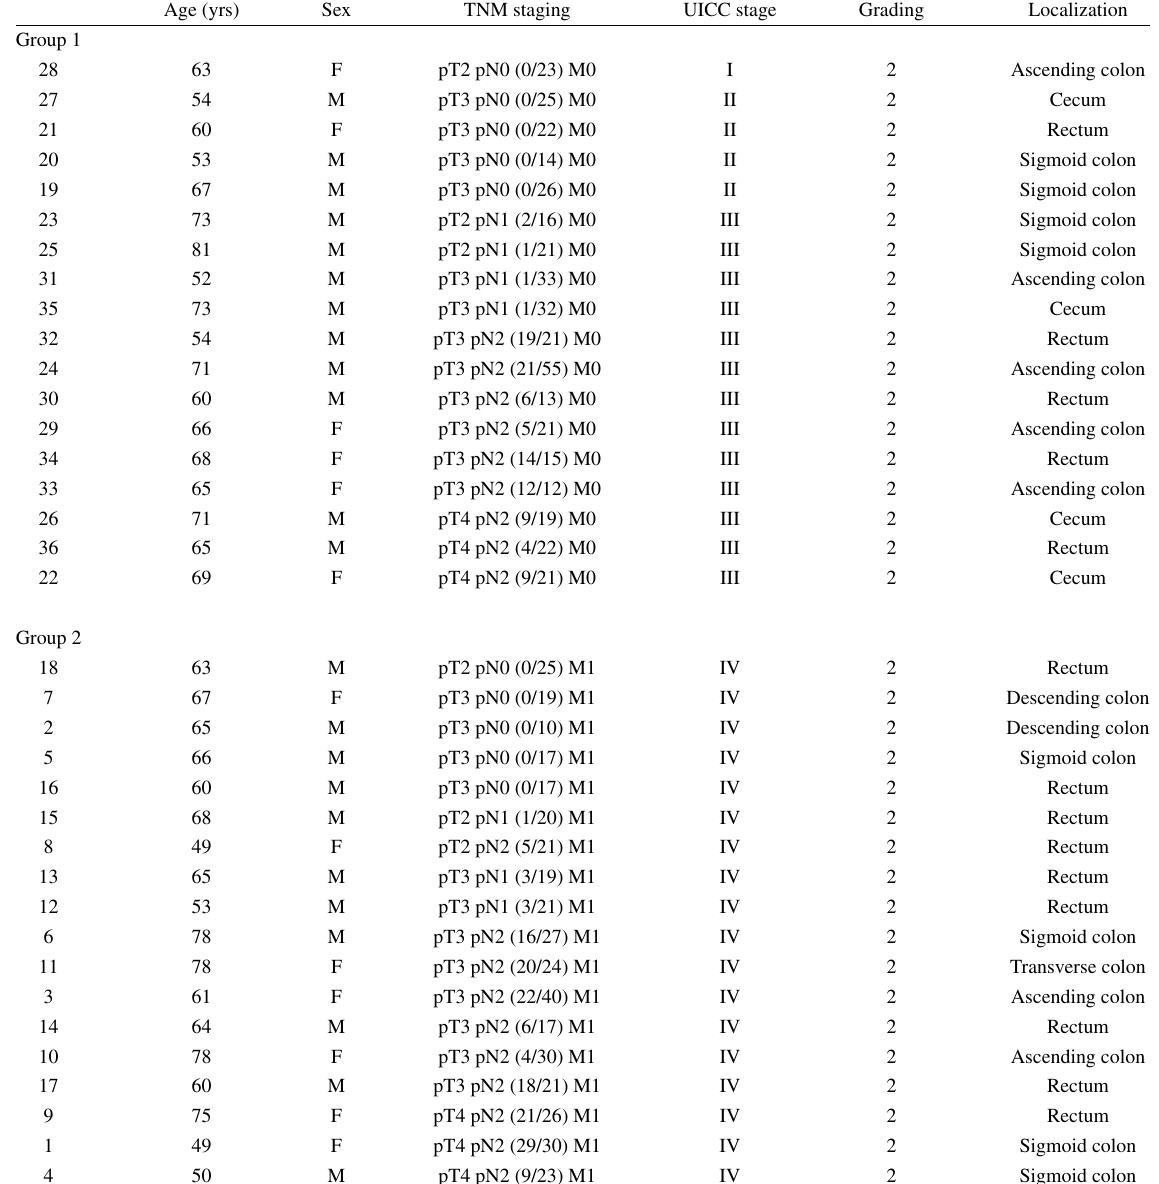
Clinical data of 36 patients with colorectal